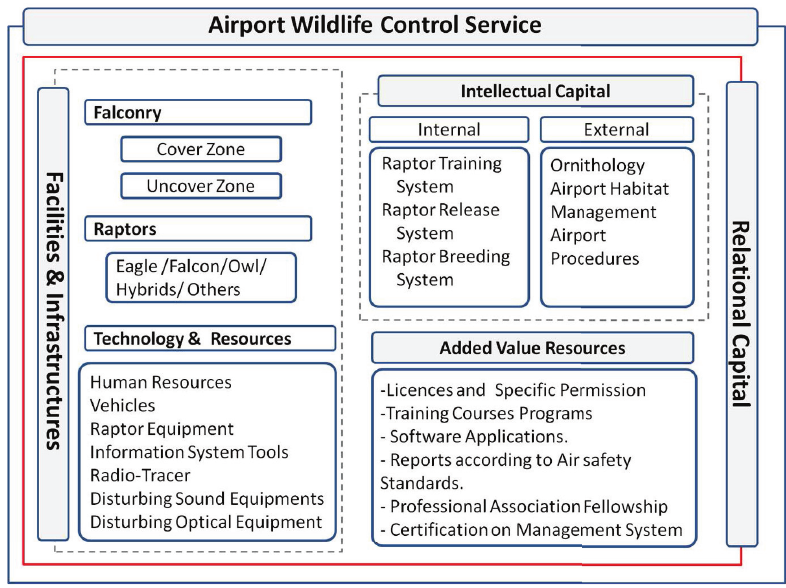
Fig. 1 knowledge Management study of Airport falconry